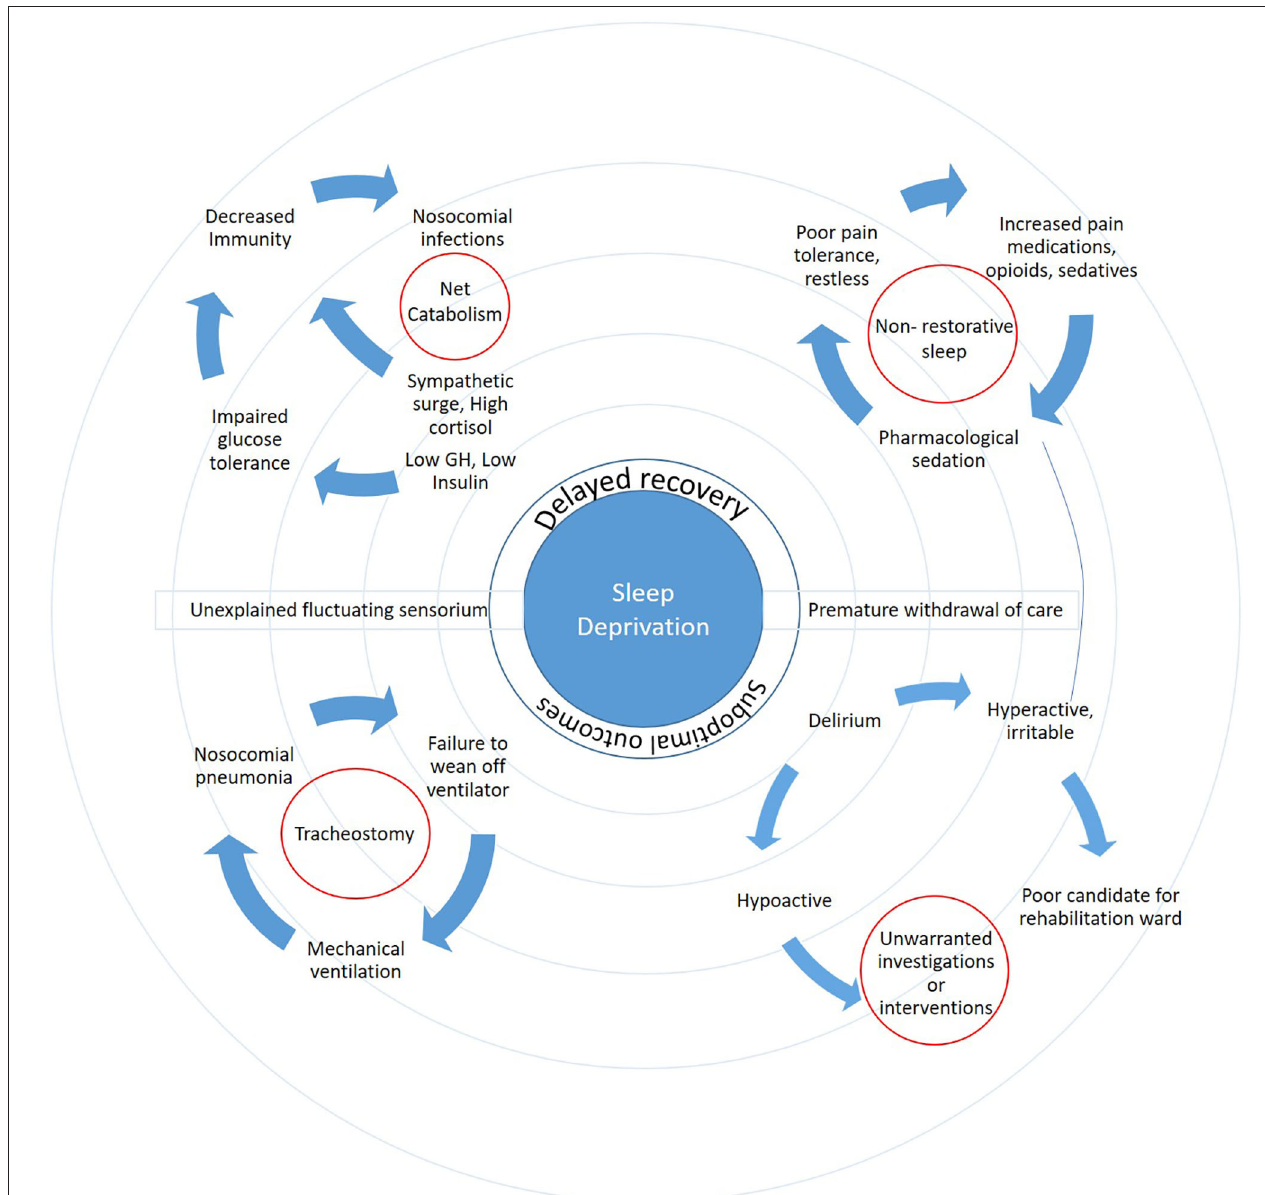
FIGURE 1 | The ripple effect of sleep deprivation highlights the complex interactions and far-reaching consequences on patient